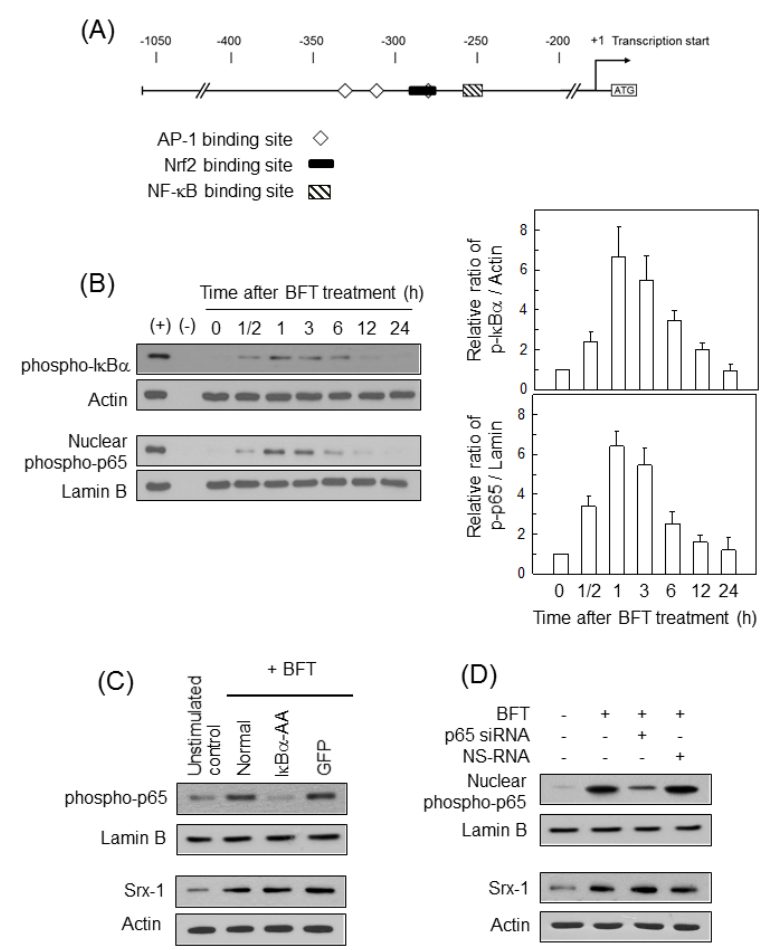
Figure 2. E ff ects of NF- κ B-suppression on Srx-1 expression in BFT-exposed HCT 116 cells. ( A ) Schematic representation of human Srx gene promoter and binding sited for potential transcription factors. JASPER 2020 (http: // jaspar.genereg.net / ) was used to identify binding sites for NF- κ B, AP-1 and Nrf2 present in the human SRX-1 promoter. Numbers indicate nucleotide position relative to the translation start site (ATG); ( B ) BFT (300 ng / mL) was added to HCT 116 cells for the indicated periods of time. In the top panels, protein expression of phospho-I κ B α and actin in whole cell lysates was examined by western blot. In the bottom panels, protein expression of phospho-p65 and lamin B in nuclear extracts was also evaluated by western blot. Right panels show densitometric analysis for expressed proteins. Positive controls ( + ) were obtained from cells that were treated with 20 µ M of TNF- α for 1 h. Values represent the relative densities of each protein compared with actin or lamin B (mean ± SD, n = 3); ( C ) HCT 116 cells were transfected with either lentivirus containing an I κ B α -superrepressor (I κ B α -AA) or control virus (GFP). BFT (300 ng / mL) was added to each group for 1 h. Protein expression of nuclear phospho-p65 was examined by western blot (top panel). In the bottom panels, BFT (300 ng / mL) was added to each group for 18 h. Protein expression of Srx-1 and actin was evaluated by western blot; ( D ) HCT 116 cells were transfected with siRNA against NF- κ B p65 or NS-RNA. BFT (300 ng / mL) was added to each group for 1 h. Protein expression of nuclear phospho-p65 was examined by western blot (top panel). In the bottom panels, BFT (300 ng / mL) was added to each group for 18 h. Protein expression of Srx-1 and actin was also evaluated by western blot. All images in ( B – D ) are representative of more than three independent